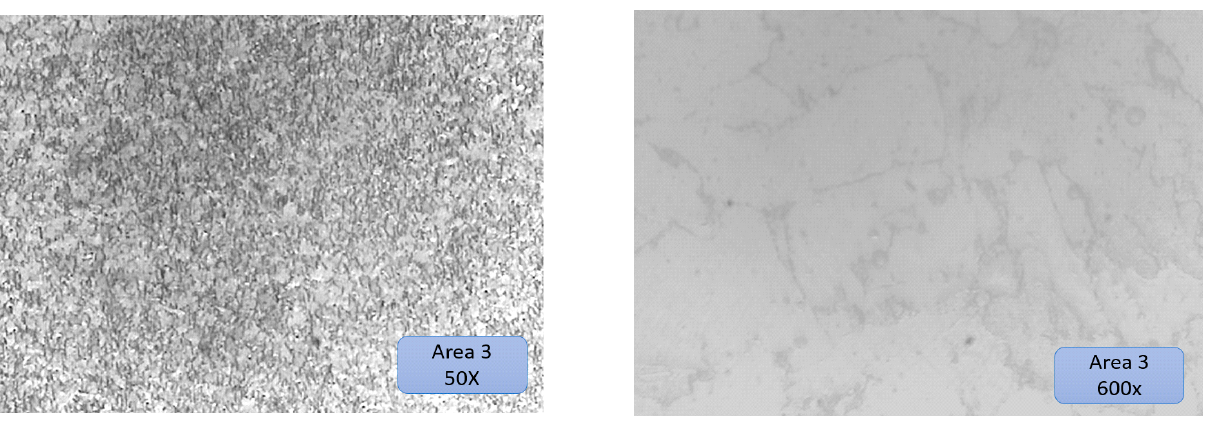
Figure 26. Substrate material area 3.